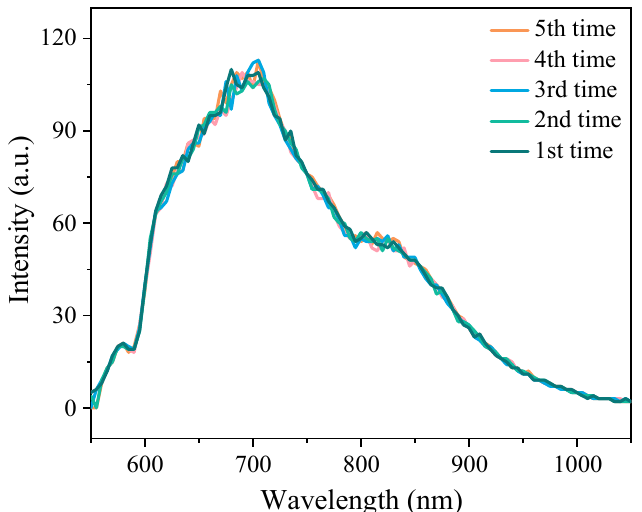
Figure 1. ( a ) Architecture of HSL system. ( b ) Prototype of AOTF-HSL.